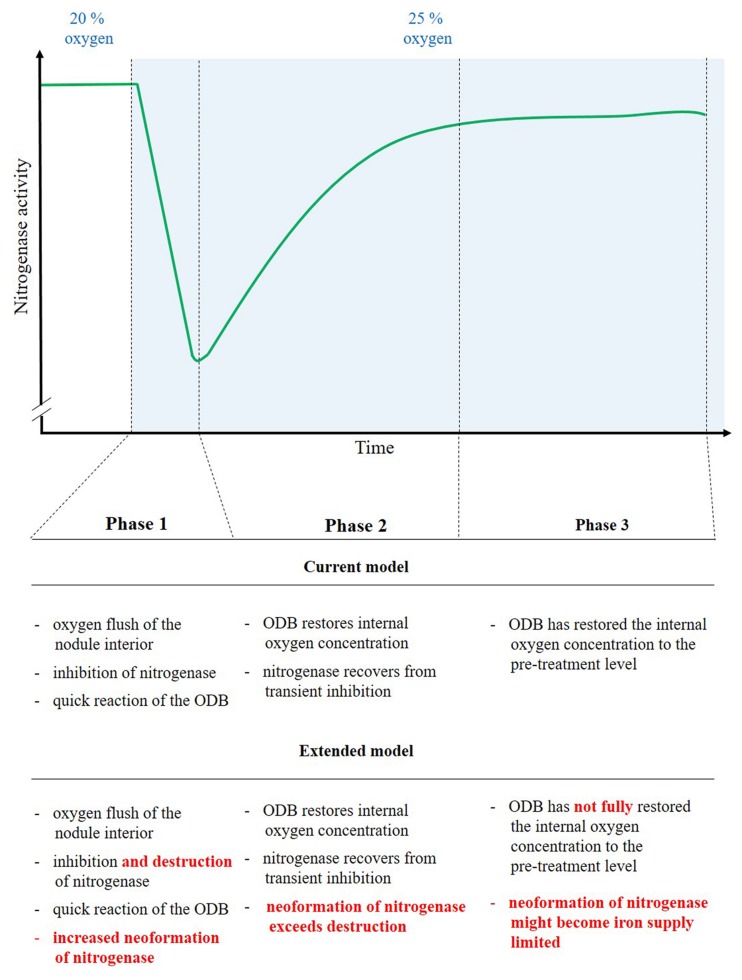
Reasons for the time-course of nitrogenase activity (H2 evolution) before and after an increase in external oxygen concentration. The green line stands for nitrogenase activity (H2 evolution). The time-period after the increase in external oxygen concentration is blue-shaded. The time-period is divided in three phases with a distinct course of nodule activity. Phase 1, as the immediate time after the increase in oxygen concentration, is characterized by a quickly starting (after about two 2 min) steep drop in H2 evolution. During phase 2 the nodule activity recovers quickly, while during phase 3 a new, more or less constant nodule activity is reached. This new level of activity is slightly below the pre-treatment level. For each individual phase, the explanation for the behavior of nodule activity in the current model and the extension of that understanding based on our data are given. The extensions are highlighted in red color.